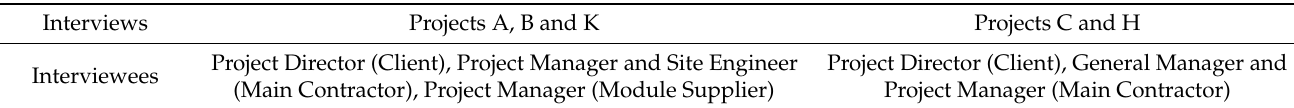
Table 2. Information of the interviewees in the within-case